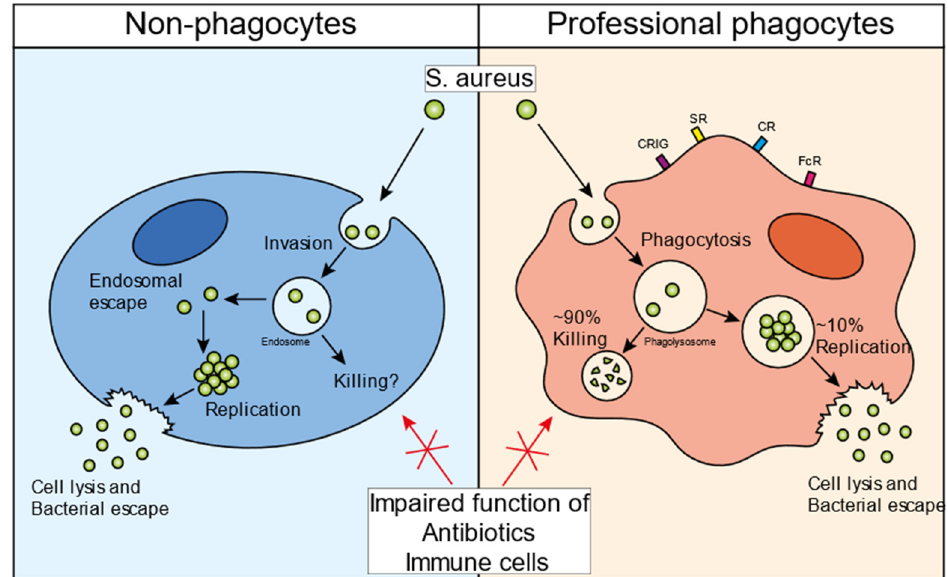
Figure 1. S. aureus infectious cycle. Schematic overview of the staphylococcal infectious life cycle in non-professional phagocytes ( left panel ) and professional phagocytes ( right panel ). S. aureus invades non-professional phagocytes and ends up inside the endosome. Various bacterial factor regulators, such as Agr and SigmaB, are important for the endosomal escape of the bacteria into the cytosol. Once inside the cytosol, bacteria can persist inside the host cells, maintaining an intracellular bacterial reservoir. Additionally, bacteria can start replicating, eventually lysing the host cell, and escaping into the extracellular environment. Professional phagocytes recognize bacteria with different receptors and take up bacteria by means of phagocytosis ( right panel ). Once inside the phagolysosome, ~90% of the bacteria are successfully killed. However, the remaining ~10% can evade the intraphagolysosomal killing strategies and then use the cells as a niche to start replicating. Similar to non-professional phagocytes, the bacteria can eventually lyse the host cell and escape into the extracellular environment. The intracellular bacteria in all cell types are protected from immune cells as well as antibiotic treatment. Abbreviations: CRIg, complement receptor of immunoglobulin superfamily; SR, scavenger receptor; CR, complement receptor; FcR, Fc